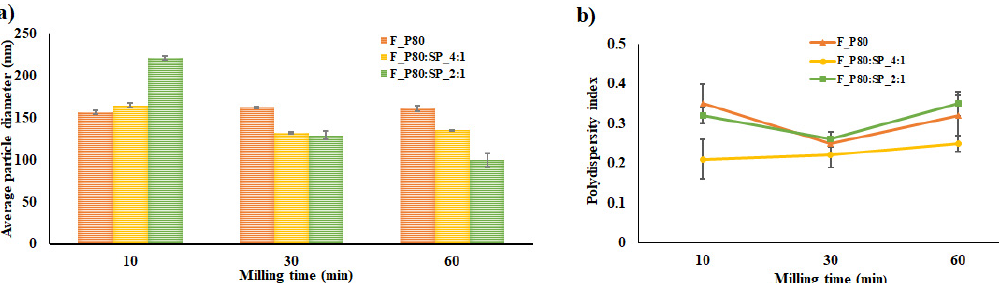
Figure 1: Polarization microscopy images of the coarse dispersions of curcumin: a) F_P80; b) F_P80/SP_4:1; F_P80/SP_2:1